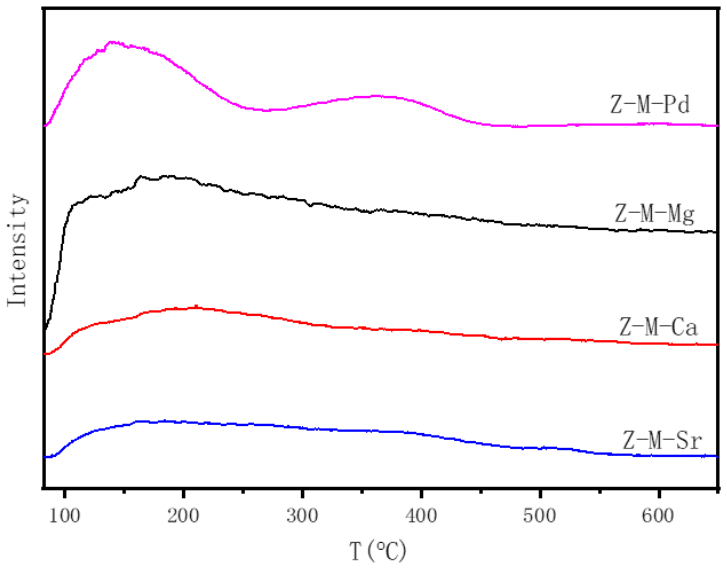
ff erent metals.